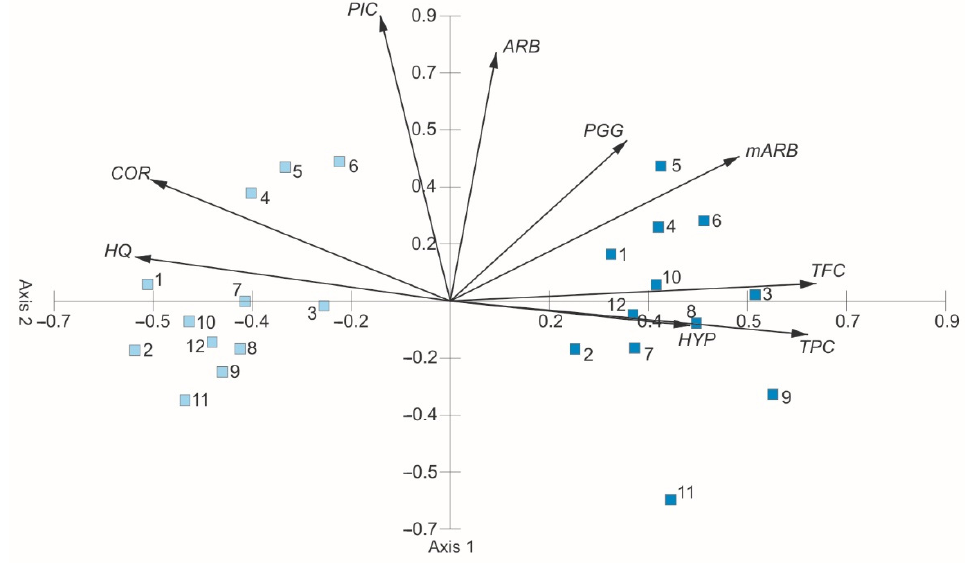
Figure 10. PCA ordination on the basis of the chemical composition of bearberry leaf extracts. TPC— total phenolic concentration, TFC—total flavonoid concentration, ARB—arbutin, HQ—hydroquinone, mARB—methylarbutin, PGG—penta-O-galloyl- β -d-glucose, PIC—picein, COR—corilagin, HYP—hyperoside.